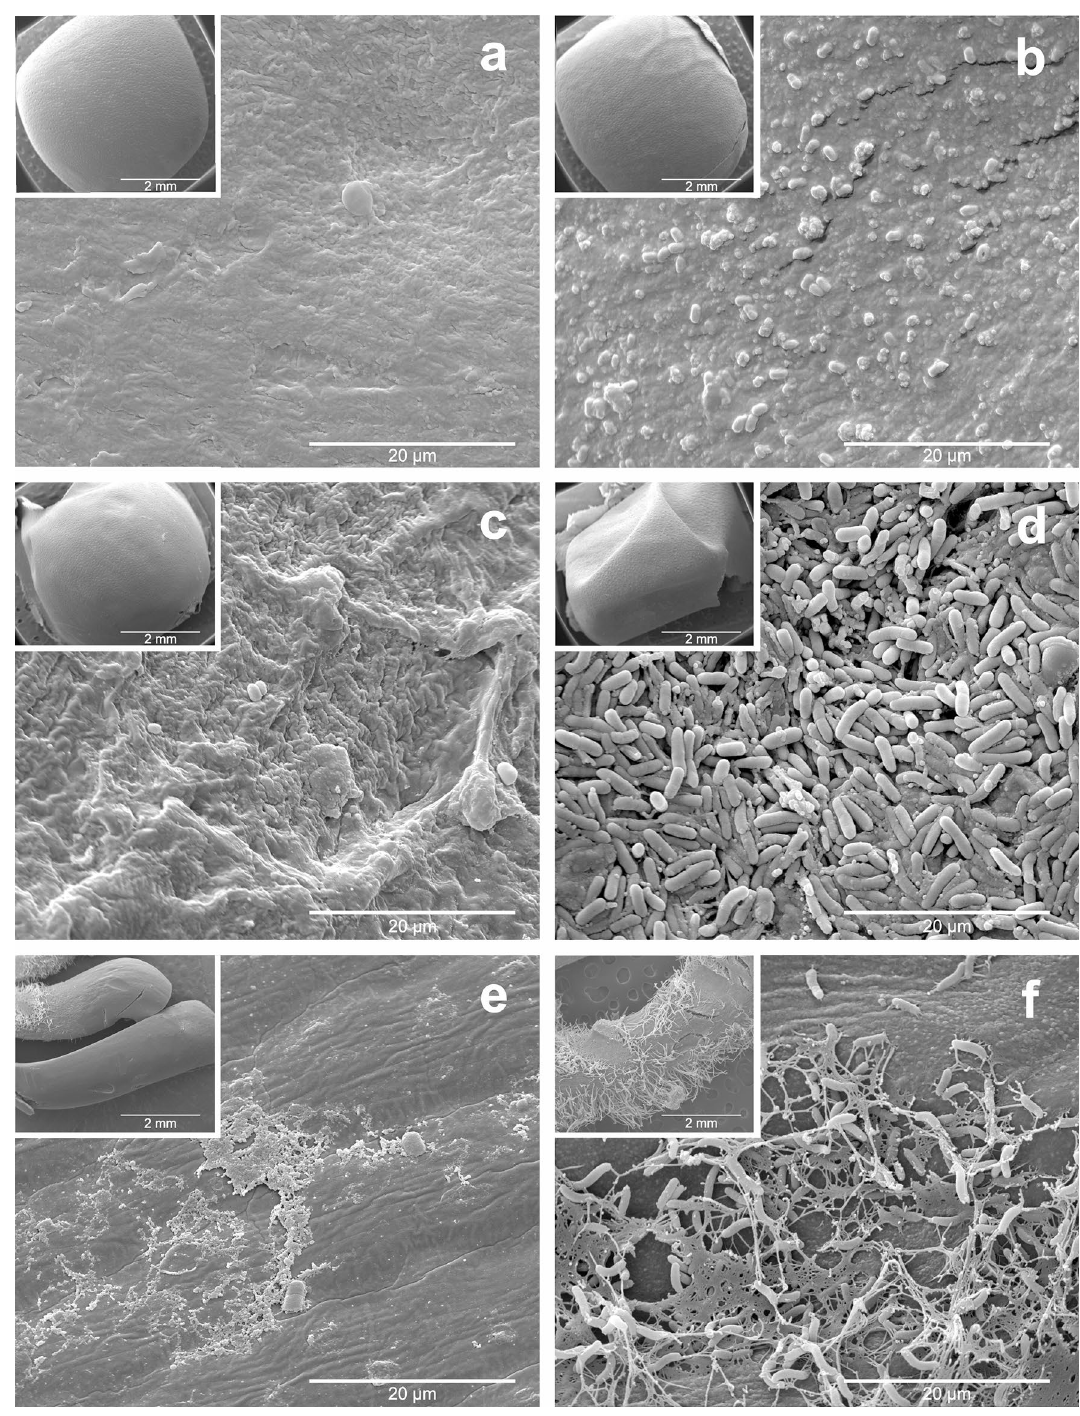
Figure 5. Scanning electron microscopy of the colonization of Bacillus velezensis CMRP4489 on soybean seeds. The first column shows untreated seeds. The second shows the seeds treated with strain CMRP4489, adjusted to 5 × 10 9 CFU/mL (200 mL/100 kg). The first row shows seeds that were fixated on day 0 of treatment; the second row shows the seeds after 7 days of incubation, and the third row shows the radicles of the seeds after 7 days of incubation. All images have inserts at 50 ×